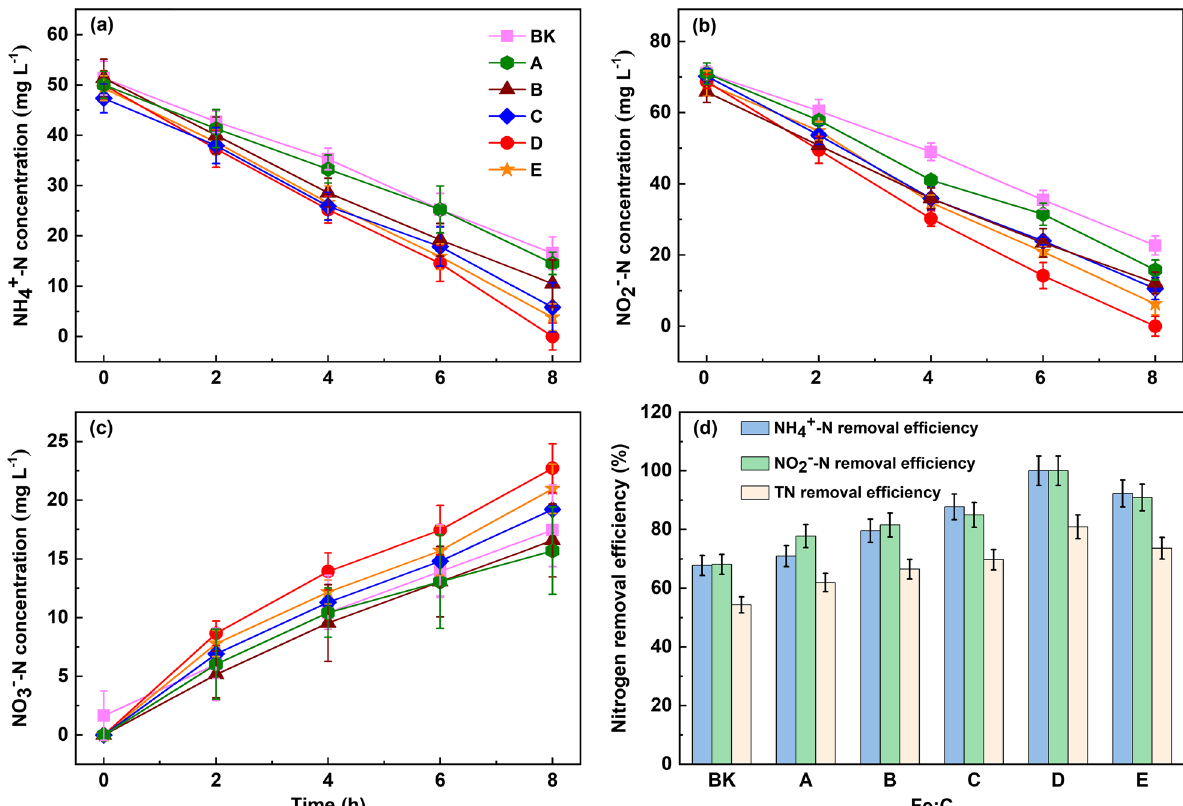
Fig. 1 Nitrogen removal performance of the six reactors under variational Fe:C ratios. a variations of NH 4 + -N concentrations; b variations of NO 2 − -N concentrations; c variations of NO 3 − -N concentrations; d nitrogen removal efficiency (NRE); BK, A, B, C, D and E represent the anammox system with the iron-charcoal ratios (Fe:C) of 0,1:1,1:2,1:5,1:10 and 1:40 biochar additions,